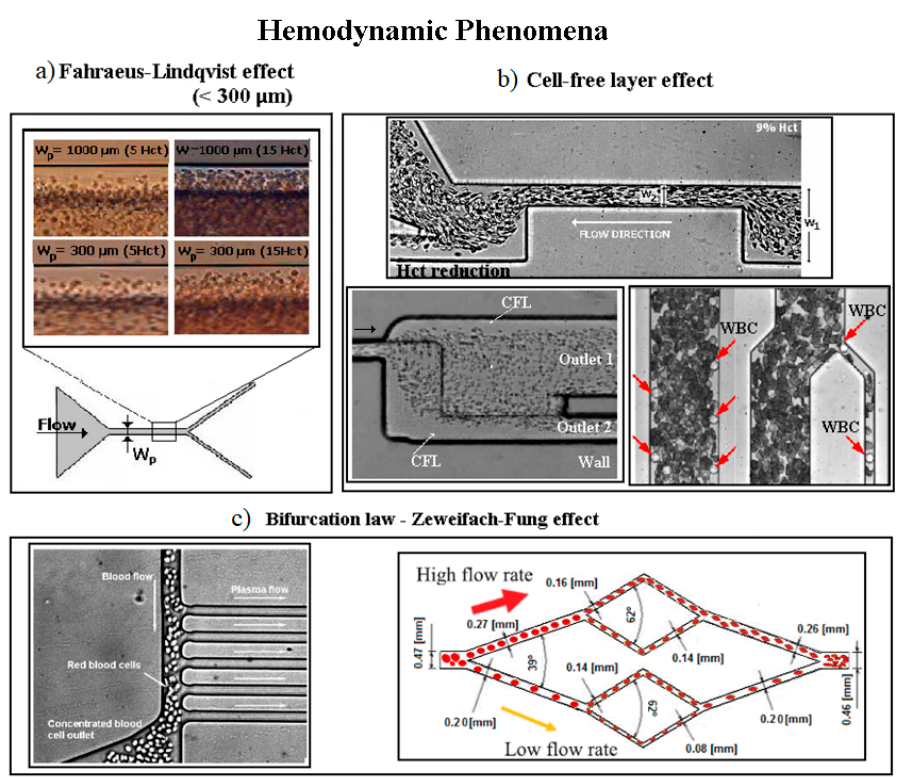
Figure 7. Blood separation microdevices based on hemodynamic flow separation techniques: ( a ) the Fåharaeus–Lindqvist effect in a microchannels with dimensions < 300 µm. Reproduced with permission from [23]. ( b ) cell-free layer as an advantage for cell and plasma separation and plasma skimming effect, WBCs margination. Adapted from [86,95,96]. ( c ) the Bifurcation law manipulated to remove cell-free plasma from blood and to mimic the microvasculature networks. Reproduced with permission from